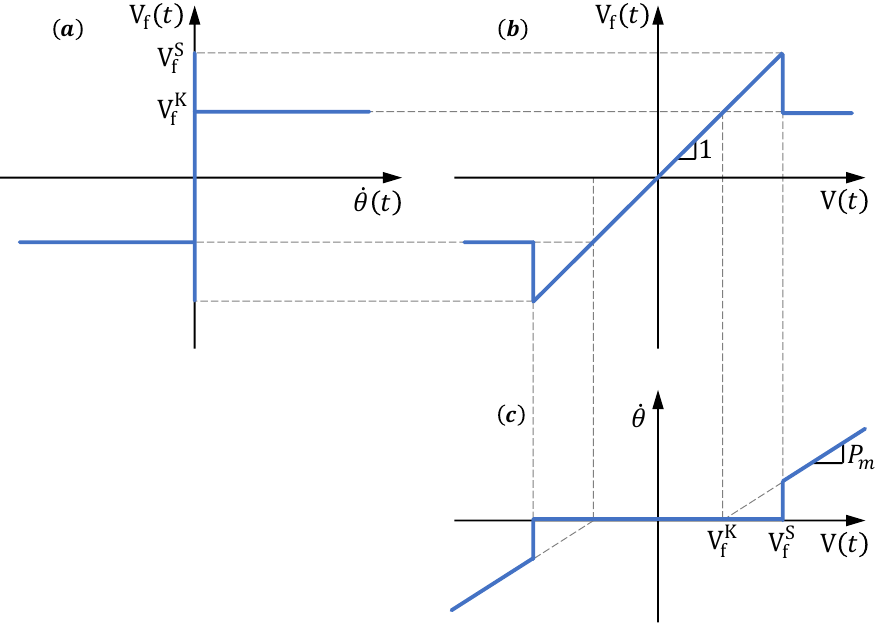
Figure 4. Friction model identification diagrams: ( a ) Friction torque against motor angular velocity, ( b ) Friction torque against motor torque, ( c ) Steady-state motor angular velocity against motor